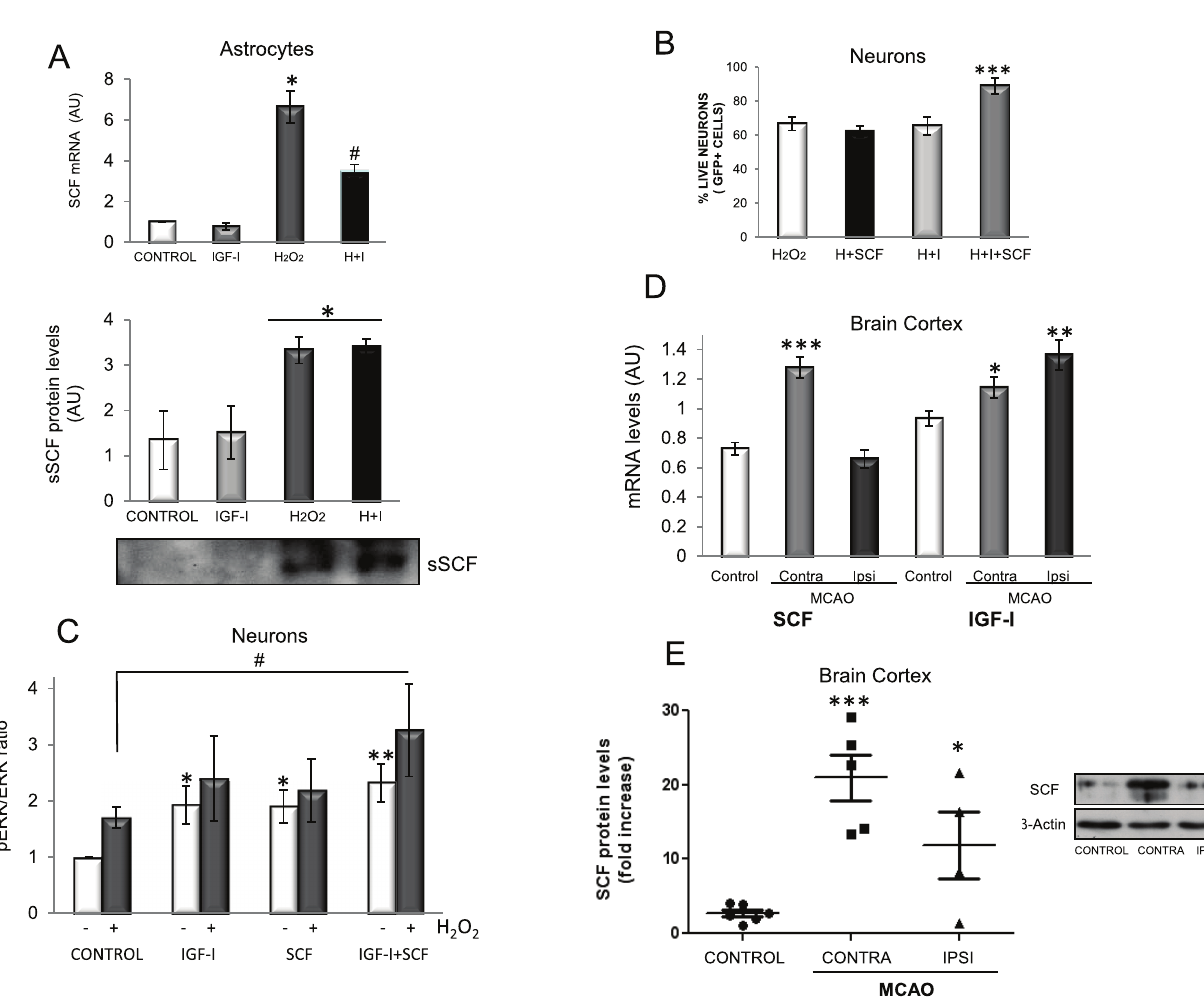
Figure 7. IGF-I cooperates with SCF to promote neuronal survival. A1 ) Upper panel: H after 16 h of exposure whereas IGF-I partially counteracts this increase (F=38.67; *p<0.05 vs. control and IGF-I, #p<0.05 vs. H A2) Lower panel: H O stimulates SCF secretion. SCF levels in supernatants from astrocyte cultures treated or not with H 2 2 for 24 h. A representative western blot is shown (*p<0.05 vs control). B ) SCF and IGF-I cooperate to protect neurons from oxidative